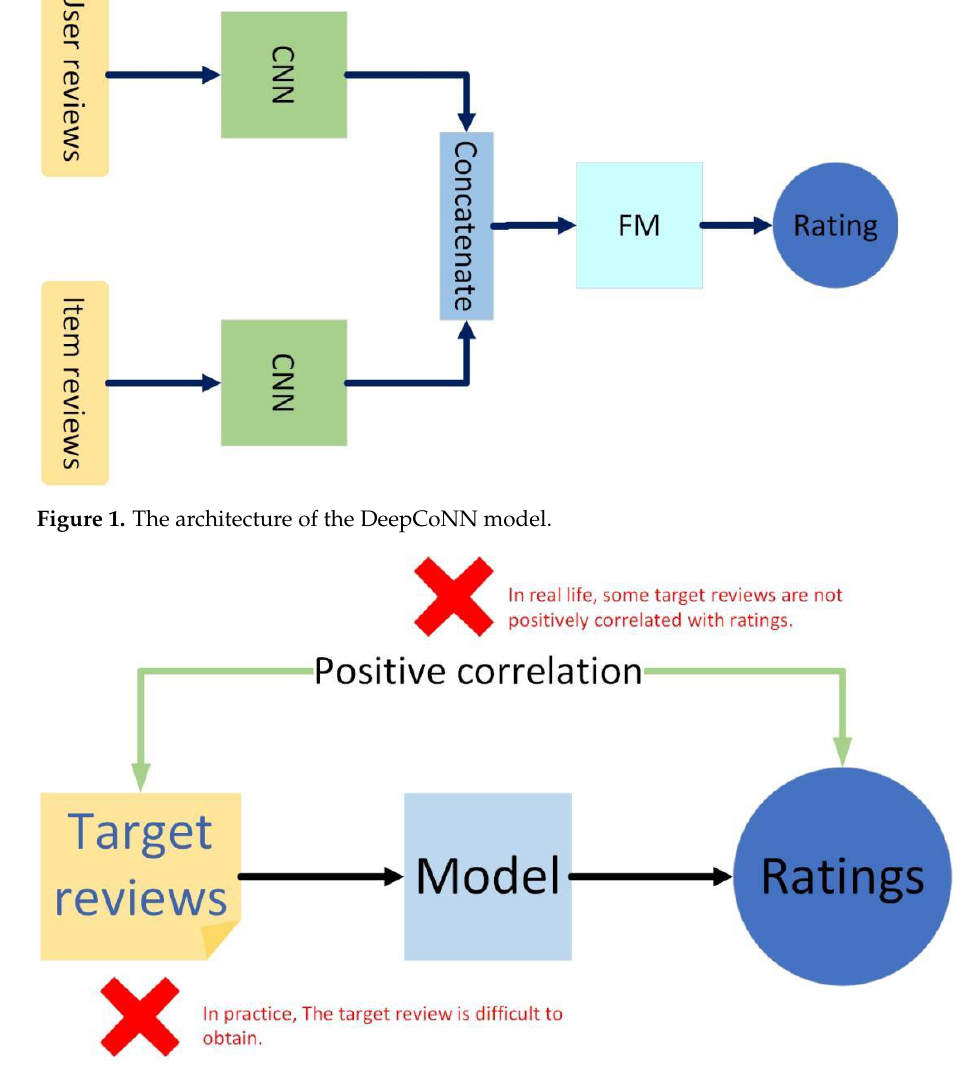
Figure 2. The problems encountered in practical life by recommendation models based on reviews.